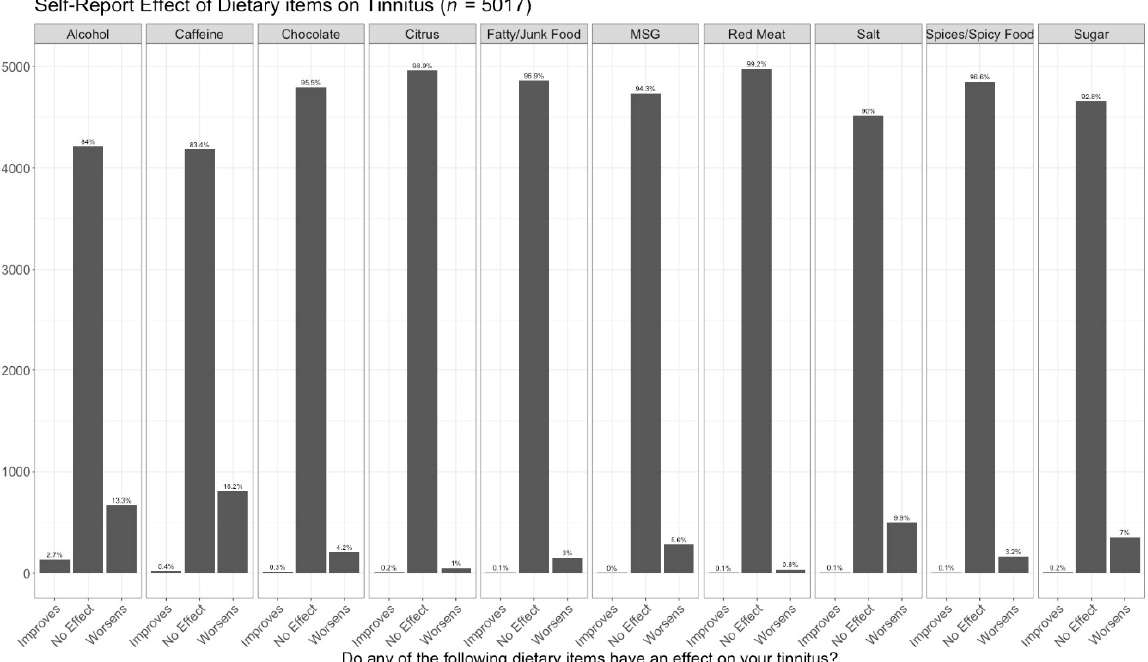
Figure 1. Reported associations of 10 dietary items with tinnitus.